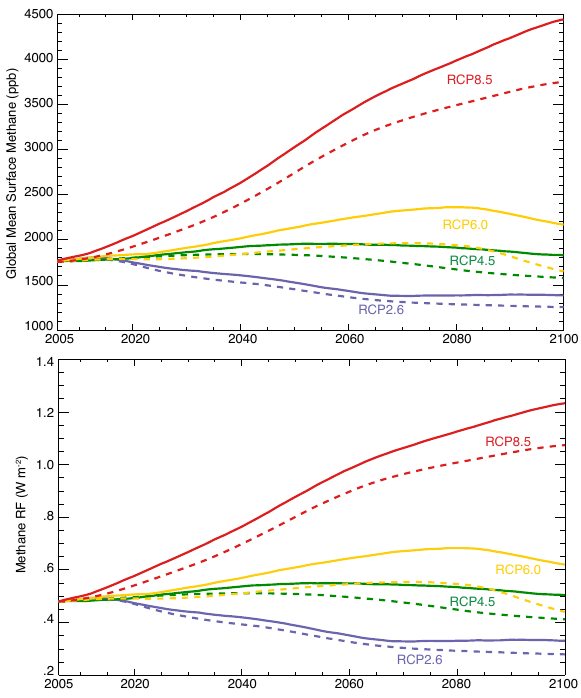
Fig. 23. Methane concentrations and forcing (W m − 2 ) relative to 1850. Concentration values (top panel) projected in the GISS model (solid lines) and the RCP values calculated with MAGICC (dashed lines), and the resulting radiative forcing (bottom panel).